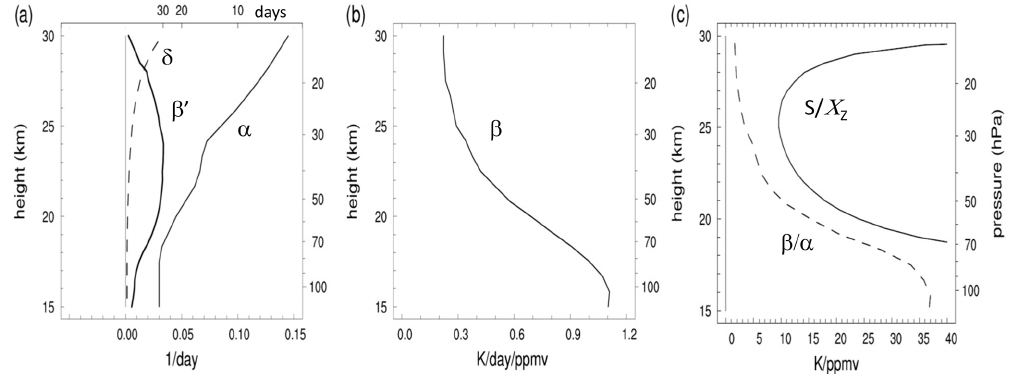
Figure 1. Vertical profiles of parameters used in the theoretical model calculations: (a) α , β (cid:48) , and δ ; (b) β ; and (c) ( S/X z ) and ( β/α ). The top axis in (a) shows the associated timescales in days.